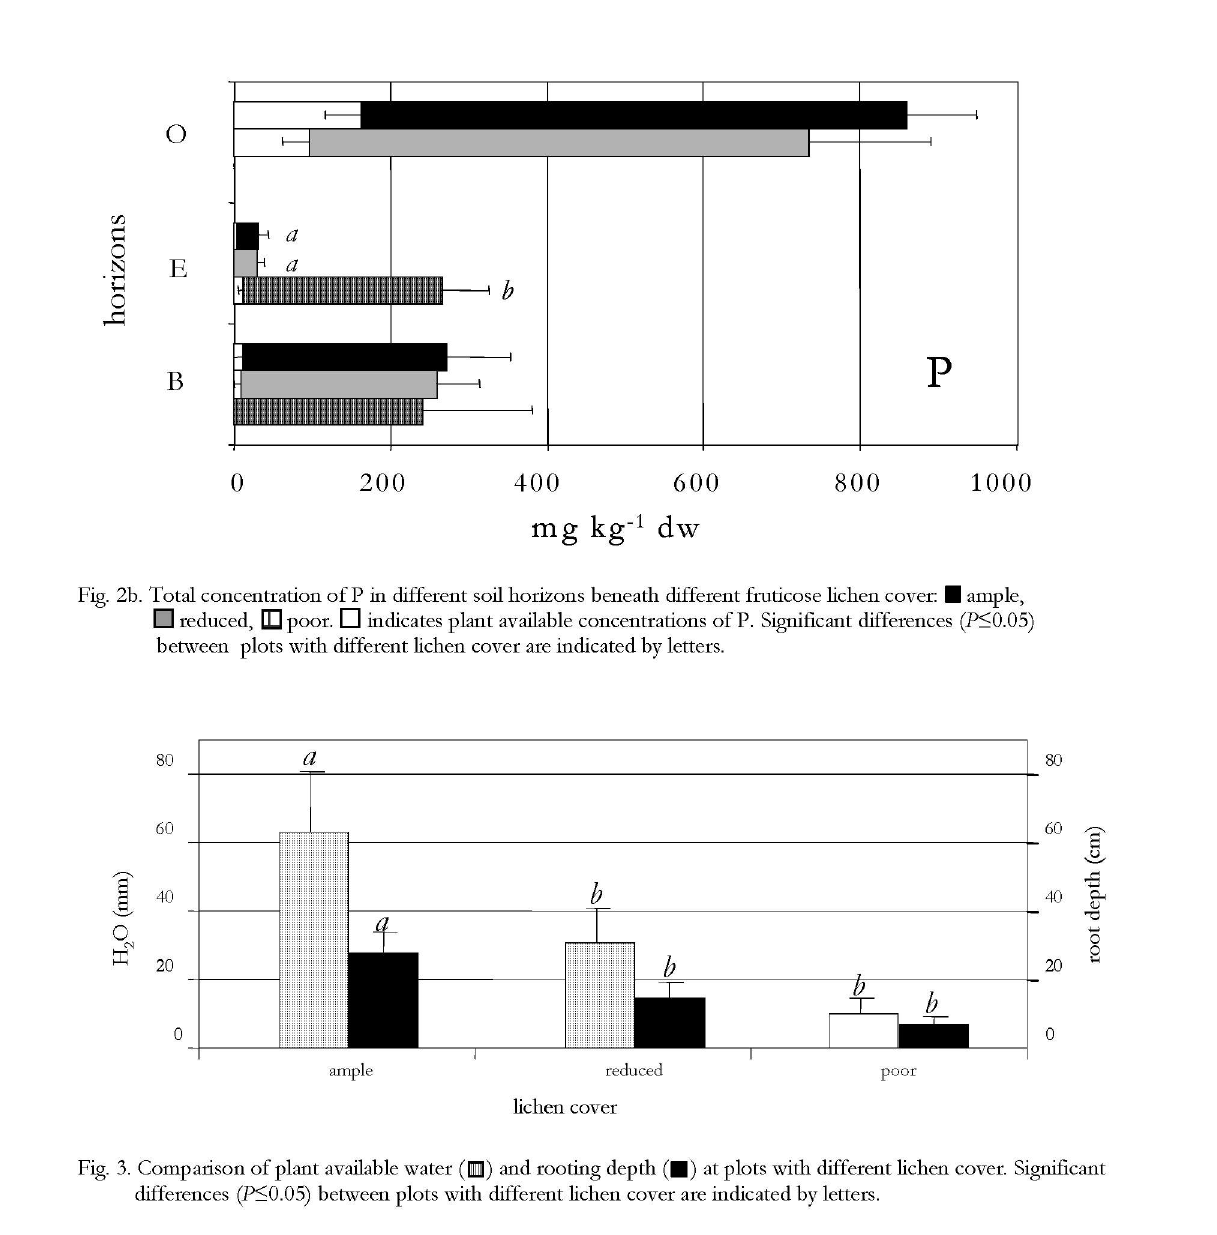
Fig. 3. Comparison of plant available water ( HQ ) and rooting depth ( • ) at plots with different lichen cover. Significant differences (P<0.05) between plots with different lichen cover are indicated by